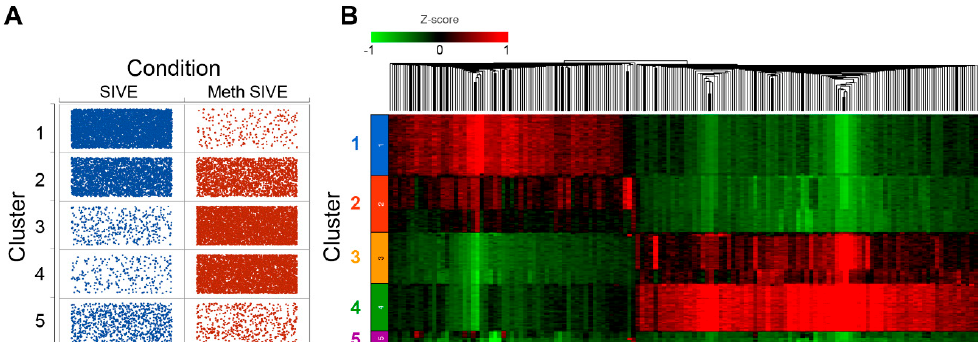
Figure 10. ( A ) Dot plot showing the number of cells (dots) in each cluster from each condition. ( B ) Heat map of hierarchical clustering of 1753 DEGs between SIVE and Meth-SIVE within the clusters, colored by expression level Z-score.